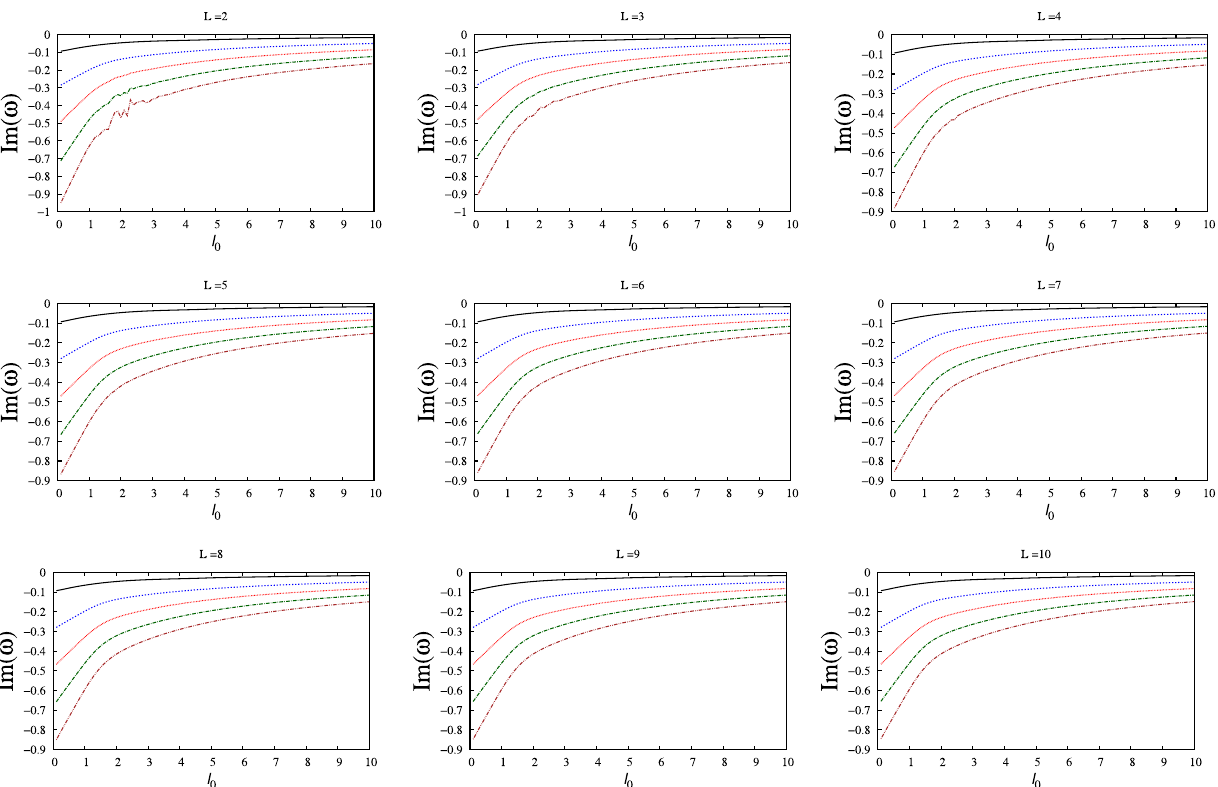
Fig. 4 Imaginary part of the QNM for Model 3 as a function of the hair α for different values of L and n . Each plot corresponds to a different value of L . The values for n are 0 (black line), 1 (blue line), 2 (red line), 3 (green line), 4 (brown